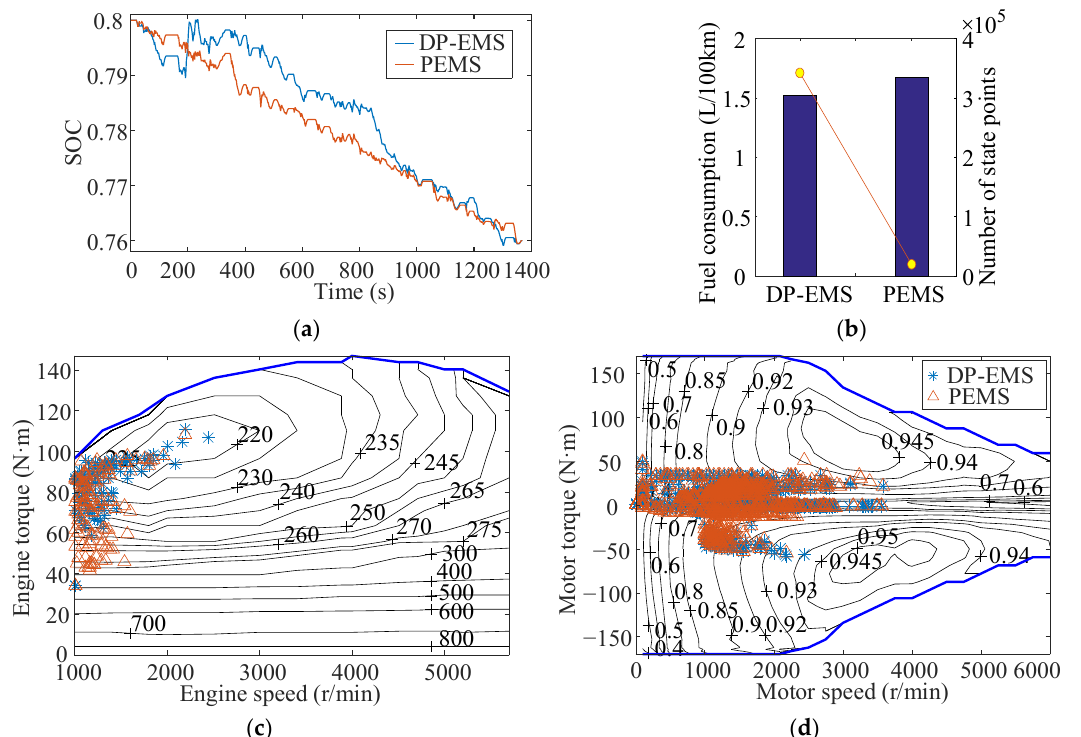
Figure 19. The simulation results of 10 s time scale under UDDS cycle. ( a ) Battery SOC; ( b ) Fuel consumption; ( c ) Engine; ( d ) Motor.